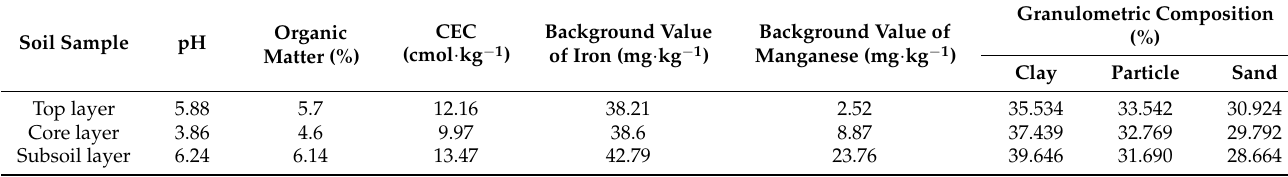
Table 1. The physical and chemical properties of each